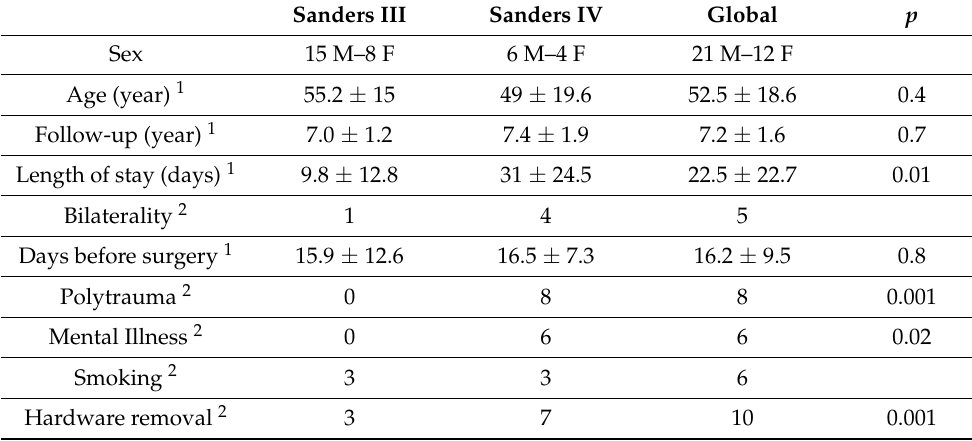
Table 1. Baseline